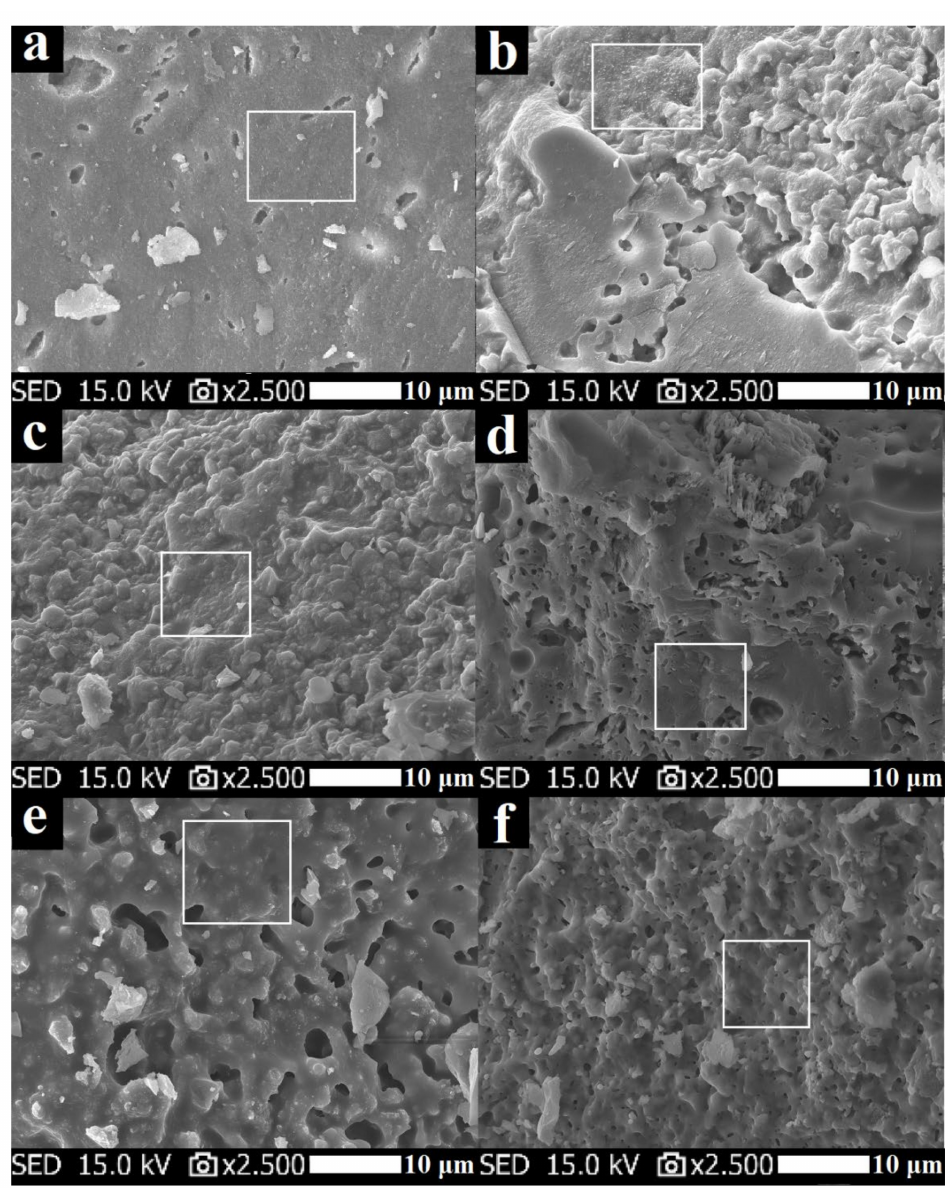
Figure 12. Micrographs of geopolymer binders with various molar ratios of K/Al (( a )—GB-0.55, ( b )—GB-0.70, ( c )—GB-0.85, ( d )—GB-1.0, ( e )—GB-1.15, ( f )—GB-1.30) after exposure to 1000 ◦